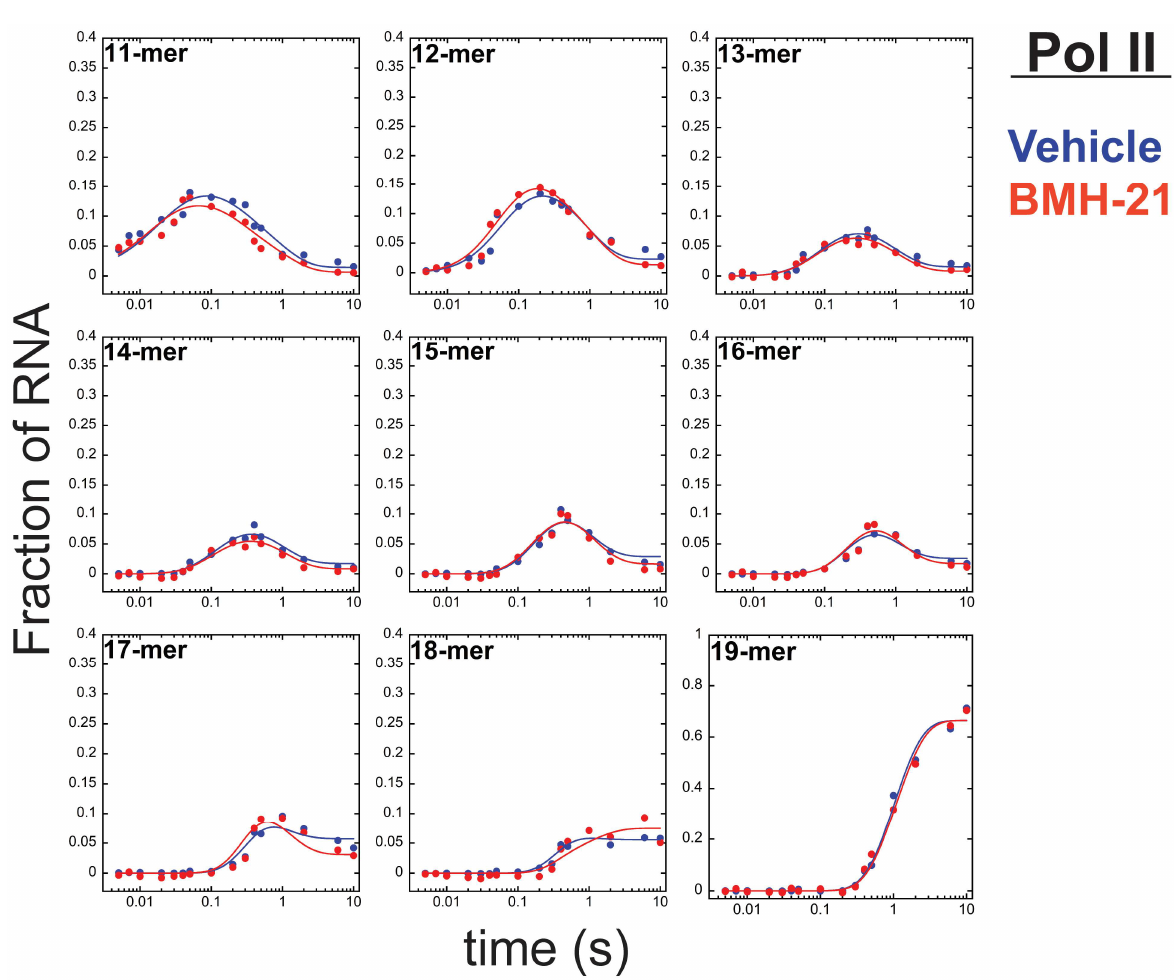
Figure 3. Pol II multi-nucleotide addition in the presence of vehicle or BMH-21. Representative data sets of the fraction of each RNA species over time fit to Scheme 3. Table 2. Ratios of forward and reverse parameter values from Pol II vehicle- and BMH-21-treated multi-nucleotide time courses.